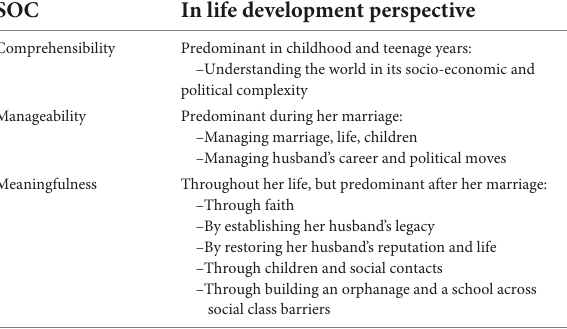
TABLE 1 Sense of coherence (SOC) in ESH’s life